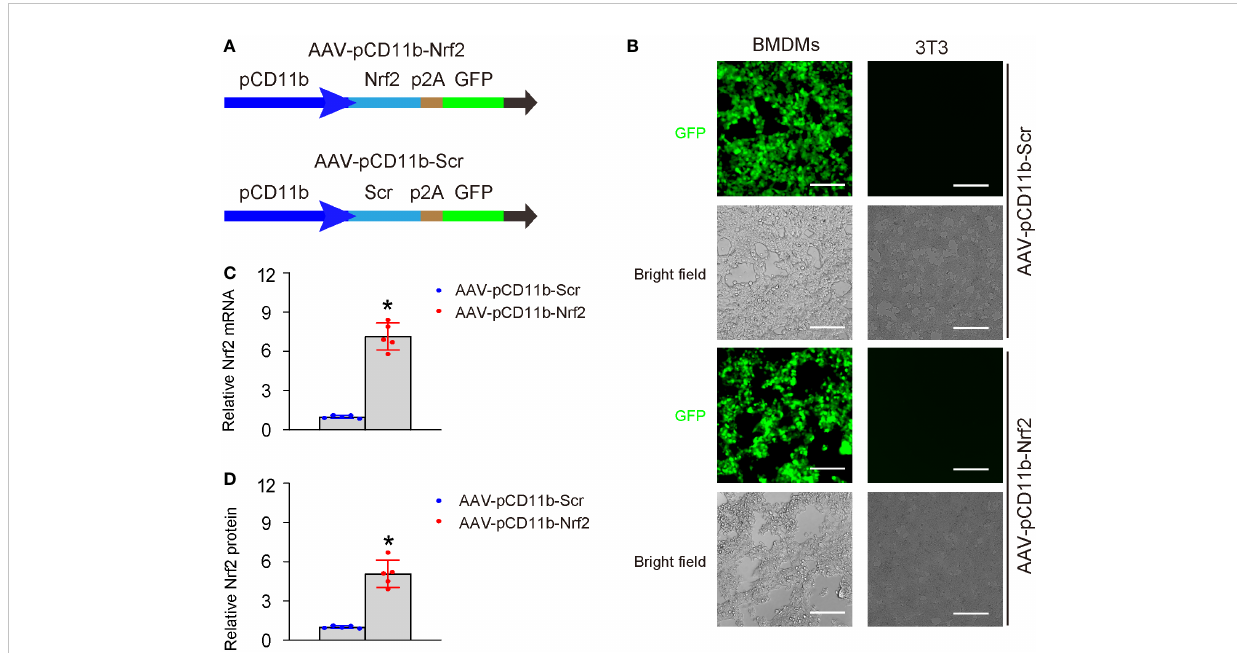
FIGURE 3 Generation of macrophage-speci fi c Nrf2-expressing vectors. (A) Schematic of an AAV (serotype 6) containing Nrf2 under the macrophage-speci fi c CD11b promoter (AAV-pCD11b-Nrf2) and a control AAV containing a scramble sequence (Scr) under the CD11b promoter (AAV-pCD11b-Scr). Both viruses also carried a green fl uorescent protein (GFP) as a reporter linked with the transgene through a p2A construct, allowing for expression of both transgenes controlled by the CD11b promoter. (B) Transduced BMDMs and 3T3 cells in vitro shown by fl uorescent and bright fi eld channels. BMDMs, but not the 3T3 fi broblast cell line, displayed green fl uorescence when transduced with both viruses, thus con fi rming the speci fi city of the CD11b promoter. (C, D) Quanti fi cation of levels of Nrf2 in transduced BMDMs, by RT-qPCR (C) and ELISA (D) . In panel D, the relative Nrf2 levels in BMDMs transduced with AAV-pCD11b-Scr were used as the reference point (=1), and the relative Nrf2 levels in BMDMs transduced with AAV- pCD11b-Nrf2 were calculated in comparison to this reference. *p<0.05. Scale bars were